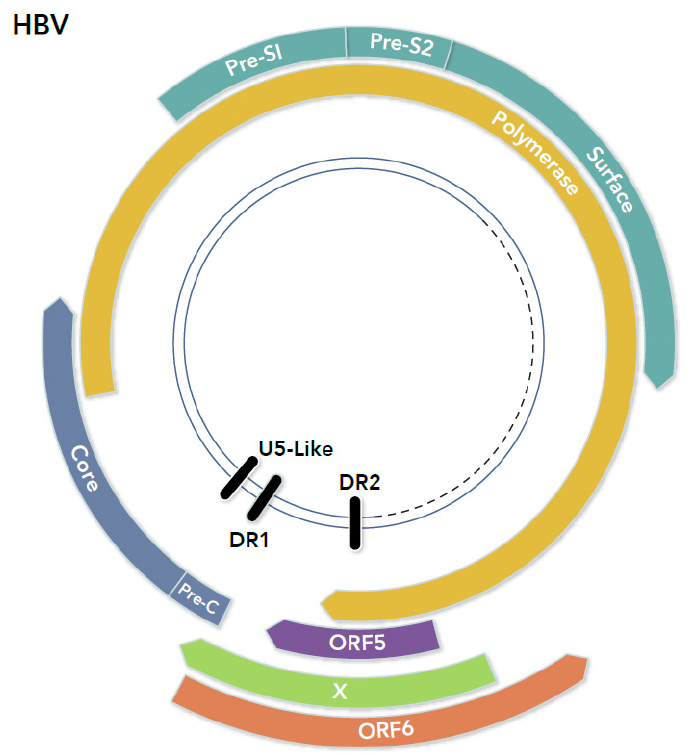
Figure 1. Open reading frames in the HBV genome. The color scheme in all figures is: for ORFs or proteins, antisense ORF (red), replicase (orange), capsid (blue), envelope (aquamarine), and regulatory (green); and for nucleotide elements (black).